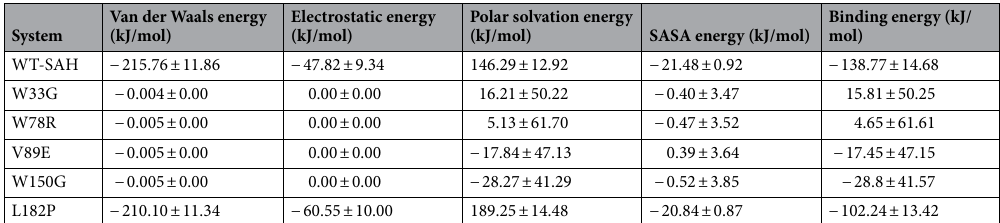
Table 5. Binding energy and its components including van der Waals, electrostatic, polar solvation and SASA energy for all six ligand-bound systems, calculated over the last 70 ns of simulation